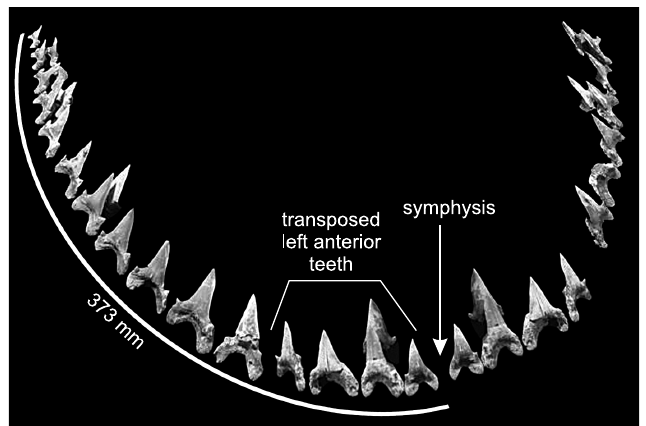
Fig. 4. Reconstructed lower dentition of Cardabiodon ricki Siverson, 1999 (WAM 96.4.45) from uppermost 10 cm of the Gearle Siltstone (middle Cenomanian), CY Creek, Giralia Range, Western Australia, depicting mir- ror images of left anterior teeth on the right